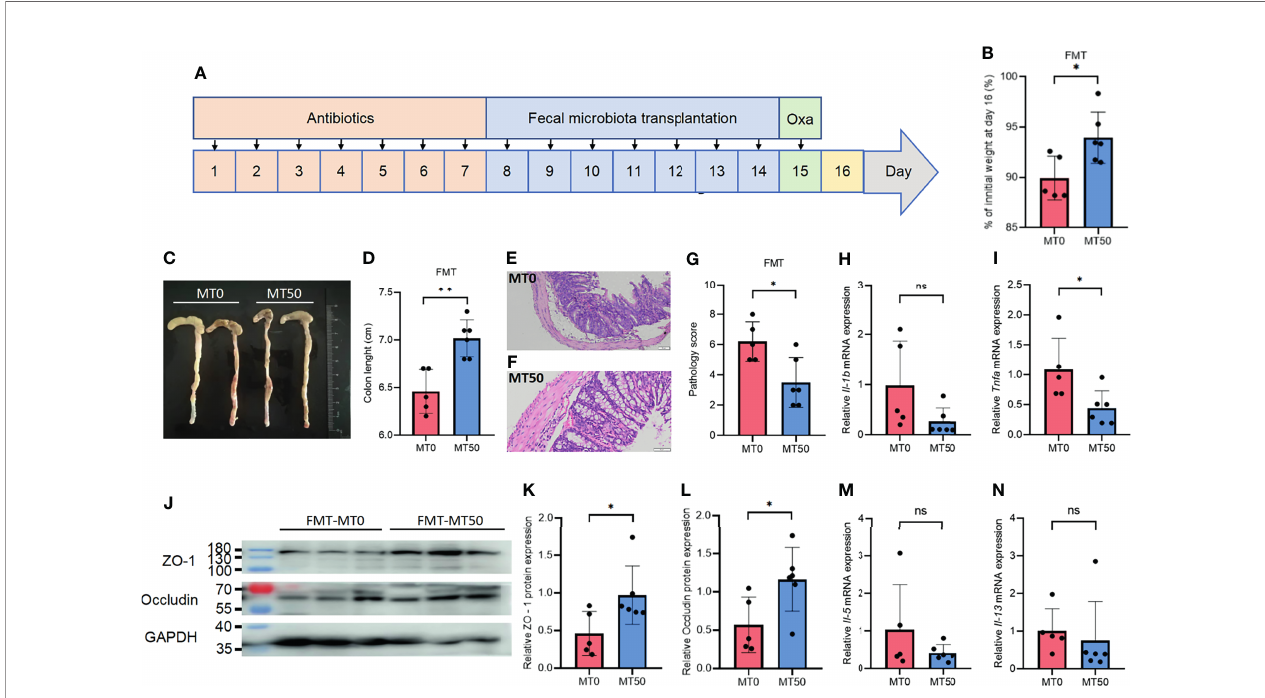
FIGURE 7 | Microbiota transplantation from melatonin-treated mice alleviates oxazolone (Oxa)-induced colitis. (A) The process of fecal microbiota transplantation. The mice were treated with antibiotics for 7 days to clear the gut microbiota (day 1 to day 7) and transplanted feces from 7-day melatonin-treated or melatonin- untreated mice (day 8 to day 14) before 3% oxazolone enema (day 15). Mice were sacri fi ced on day 16. (B) Body weight changes in fecal microbiota transplantation (FMT) mice at day 16. (C, D) Colon length in FMT mice at day 16. (E – G) Representative H&E staining (×20) and pathological score of the in fl amed gut epithelium. (H, I) qPCR of Tnfa and Il-1b mRNA in colonic tissues in FMT mice at day 16 after 3% oxazolone enema (all values were normalized to MT0 group). (J – L) Immunoblot and densitometric analyses of ZO-1 and occludin in FMT mice at day 16 after 3% oxazolone enema. (M, N) qPCR of Il-5 and Il-13 mRNA in colonic tissues in FMT mice at day 16 after 3% oxazolone enema (all values were normalized to MT0 group). Data are representative of two independent experiments. Data are shown as mean ± SD. * p < 0.05; ** p < 0.01; *** p < 0.001. ns, no signi fi